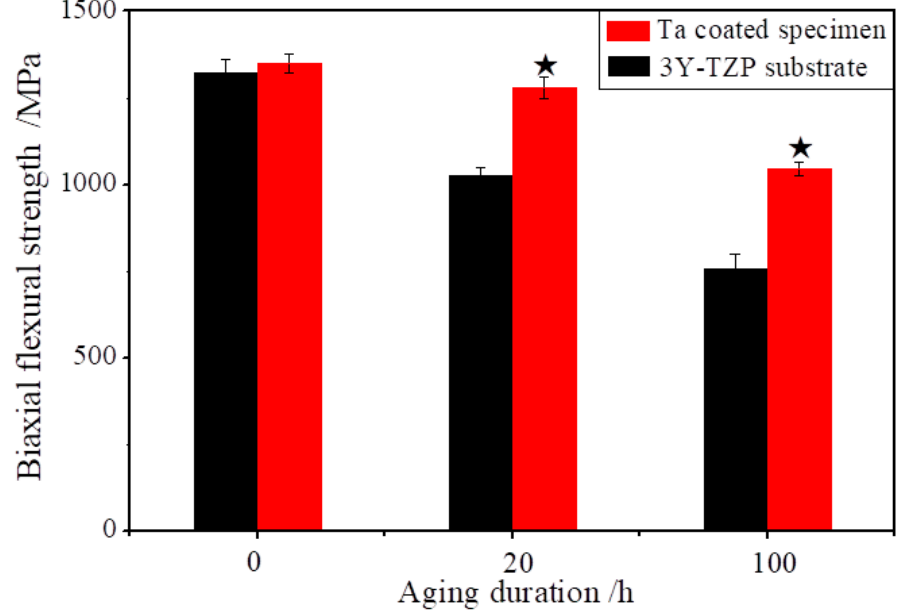
Figure 6. The effect of Ta coatings on the biaxial flexural strength after hydrothermal aging duration